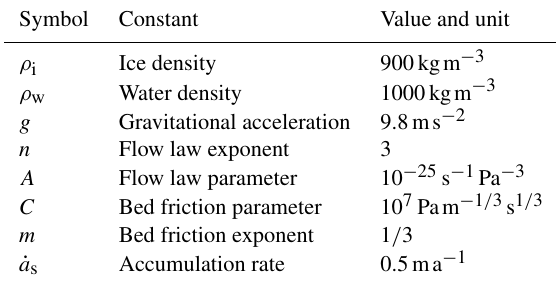
Table 1. Parameters used in Elmer/Ice and